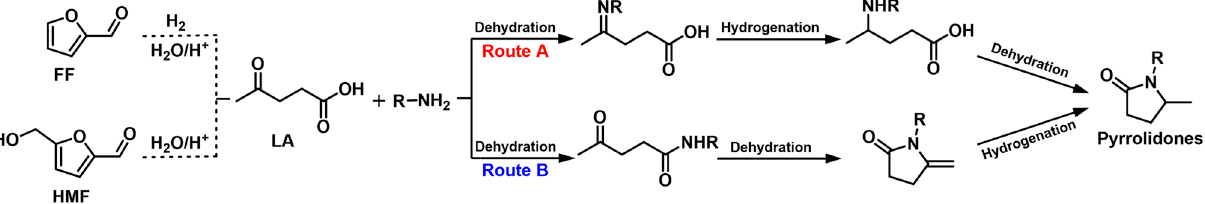
Figure 8. General reaction pathways for the reductive amination of LA with different primary amines.